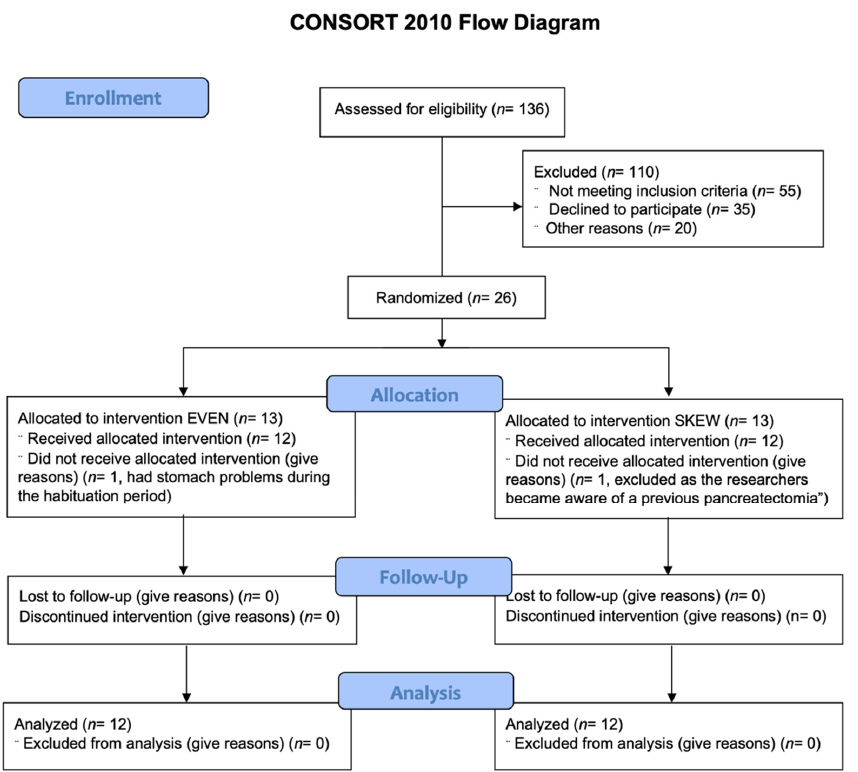
Figure 1. CONSORT diagram. 136 potential subjects were assessed for eligibility. 110 were excluded either due to not meeting inclusion criteria (55), declining to participate (35) or other reasons (20), leaving 26 subjects fit for inclusion. The 26 remaining subjects were randomized to either the EVEN or SKEWED intervention group. 1 subject from each intervention group were lost during the habituation period, leaving 12 subjects in each intervention group that all completed the entire study and who were all included in the later analysis.